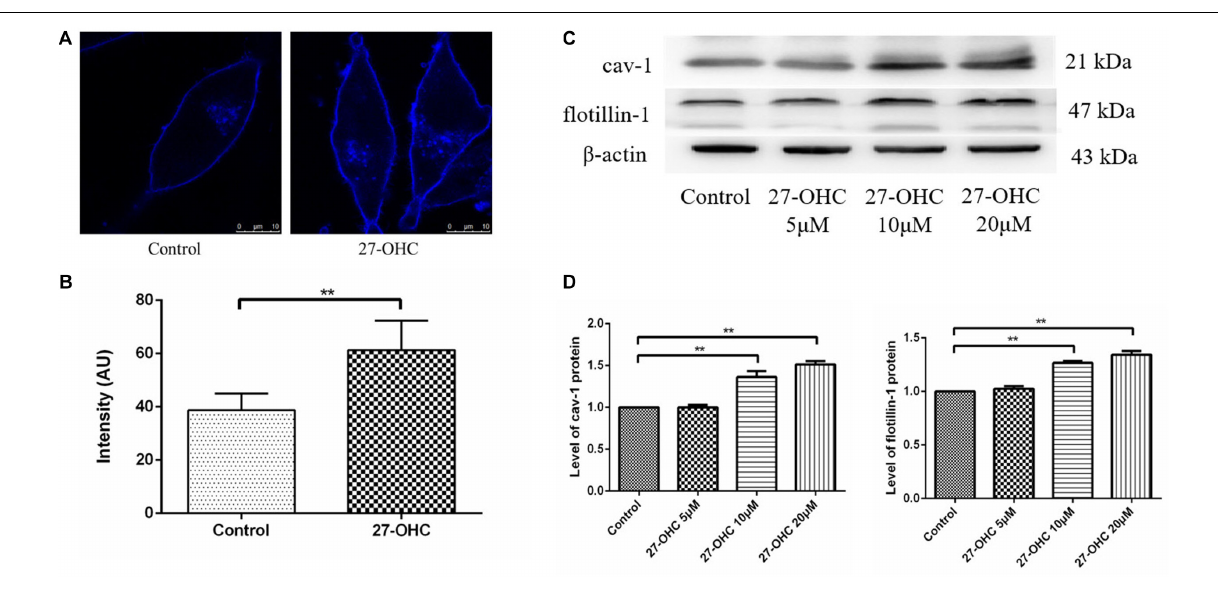
Frontiers in Cell and Developmental Biology |